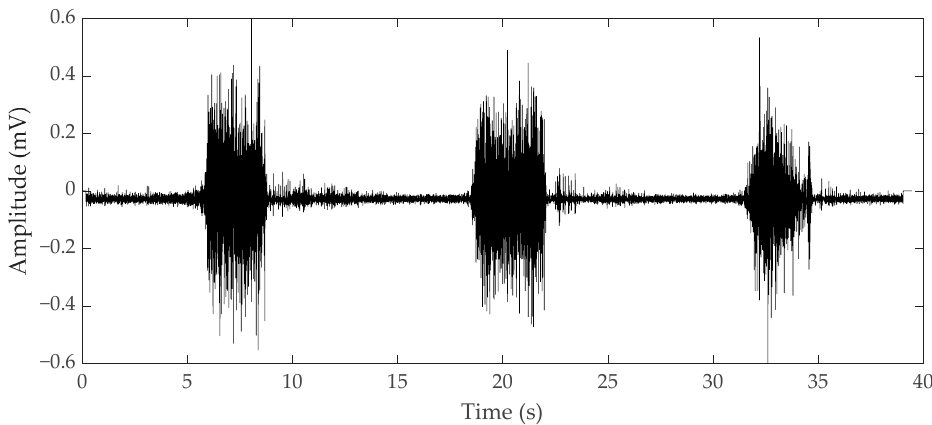
Figure 1. Electromyography (EMG) raw data during bicep brachii contraction and relaxation.